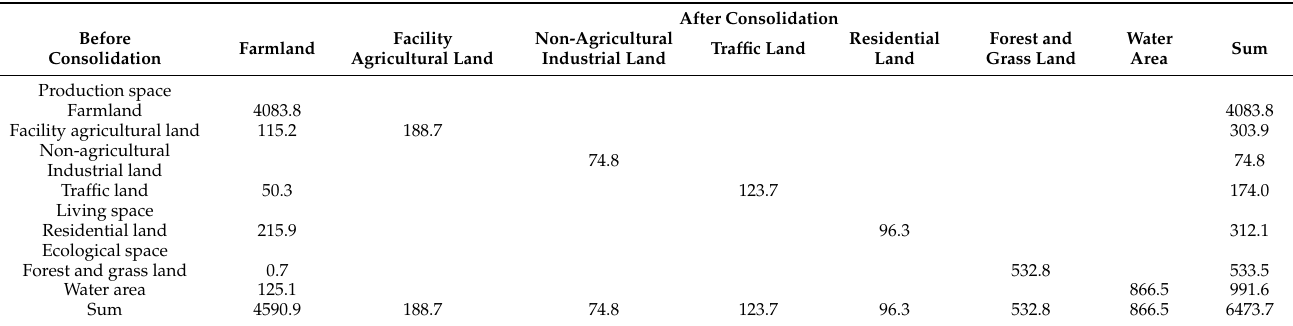
Table 1. Land-use transfer matrix in the case study area (unit: ha).